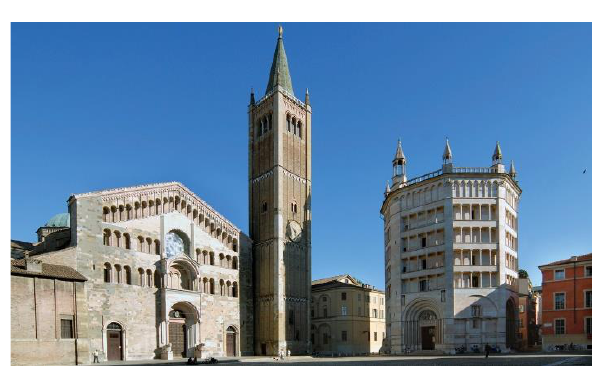
Figure 4. Piazza Duomo